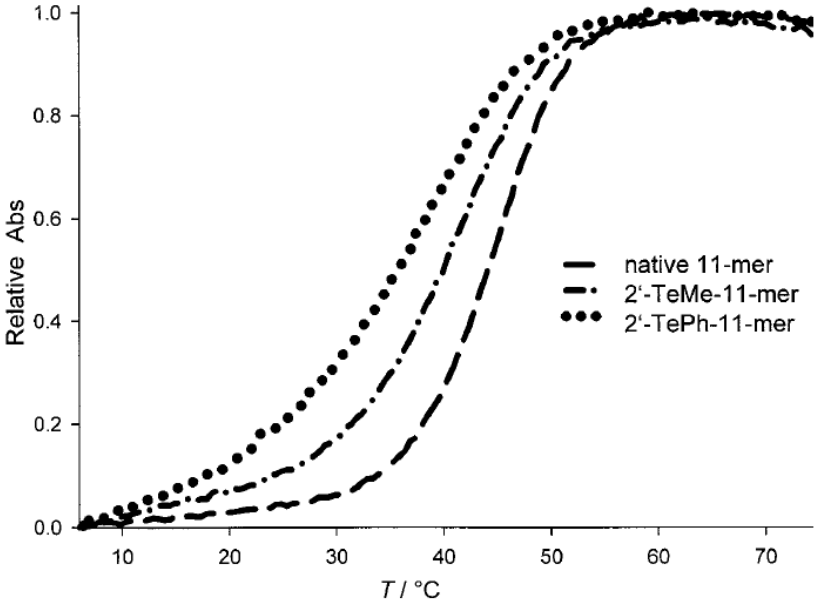
Figure 1. UV melting curves of DNA duplexes (5 ′ -C(TeXU)TCTTGTCCG-3 ′ and 3 ′ -CGGACAA- GAAG-5 ′ ; X = Me or Ph).